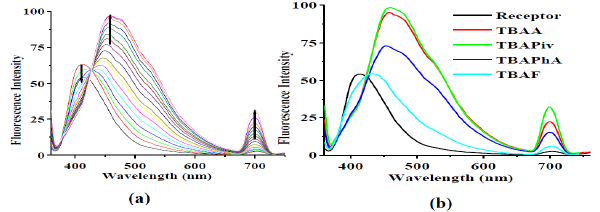
Figure 33 : Color change of 35 .